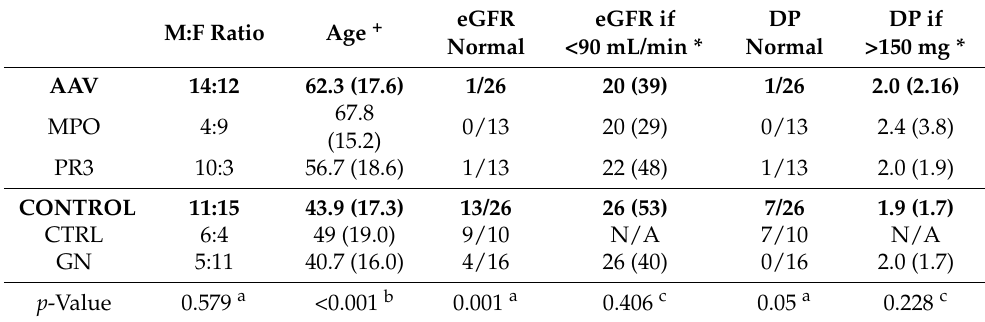
Table 2. Demographic and clinical characteristics of patients and controls by